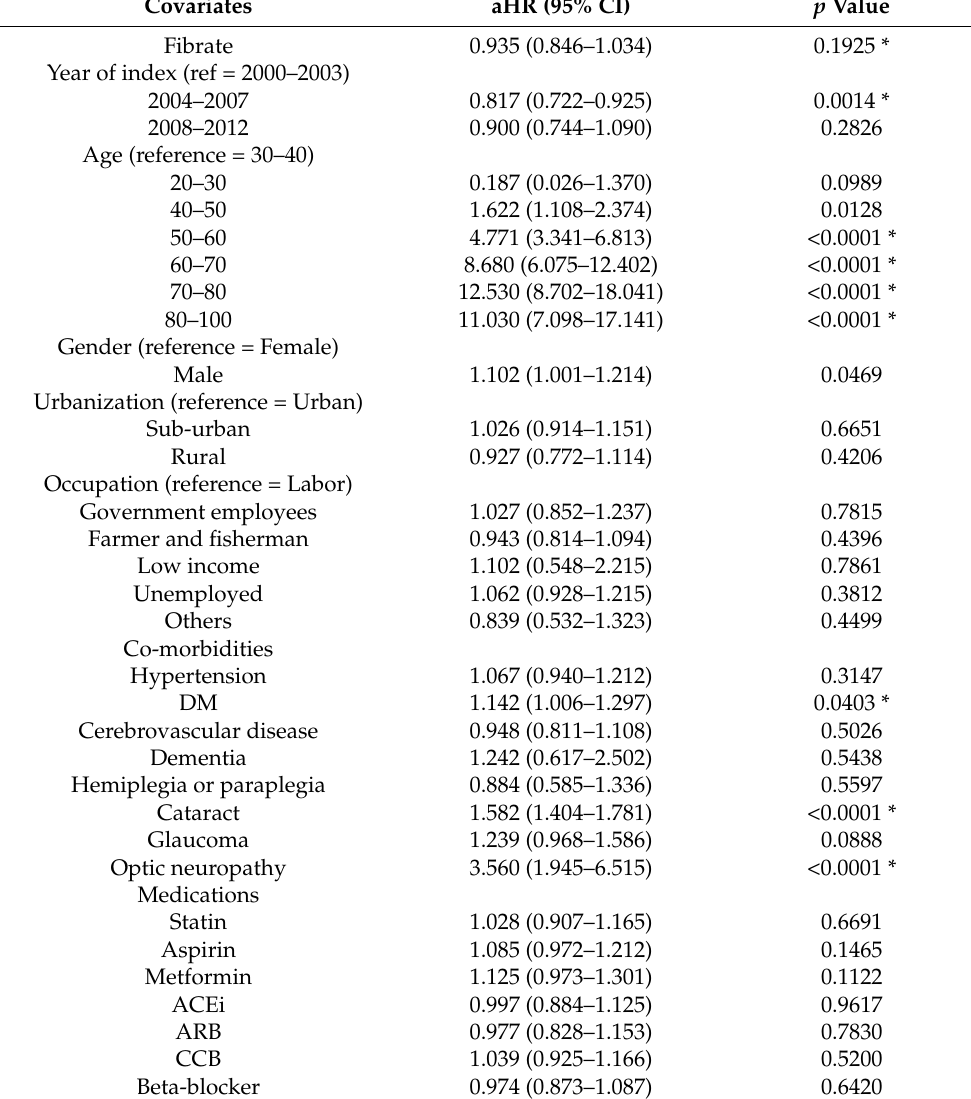
Table 4. Cox regression for estimate the hazard ratio of age-related macular